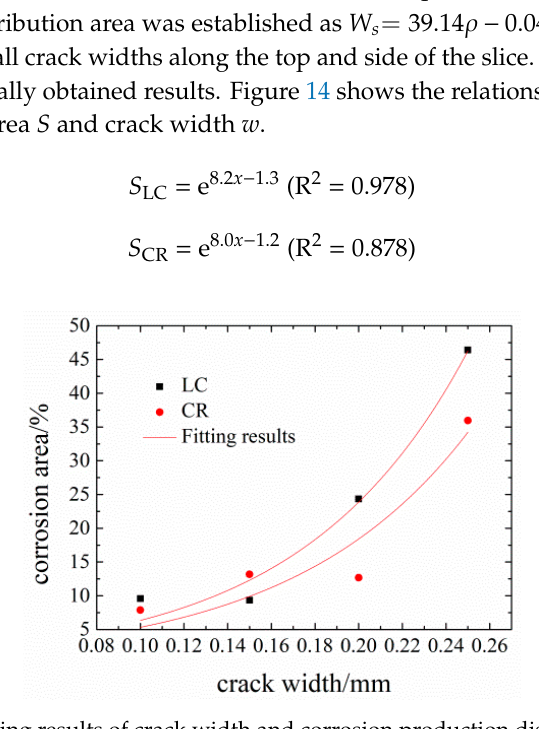
Figure 14. Fitting results of crack width and corrosion production distribution area.